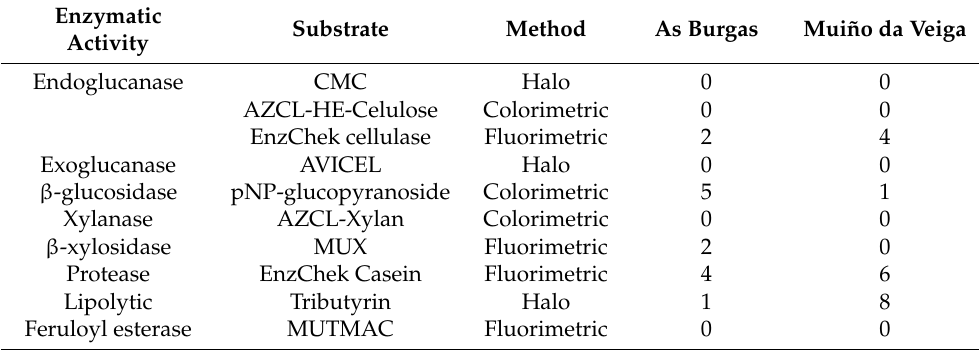
Table 1. Overview of all the functional screenings performed on the two metagenomic libraries and the number of positive hits detected for each specific